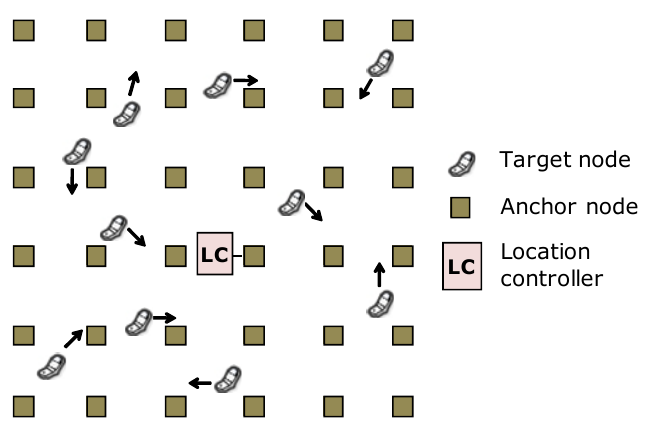
Figure 3. Tracking system. Centralized architecture with 1